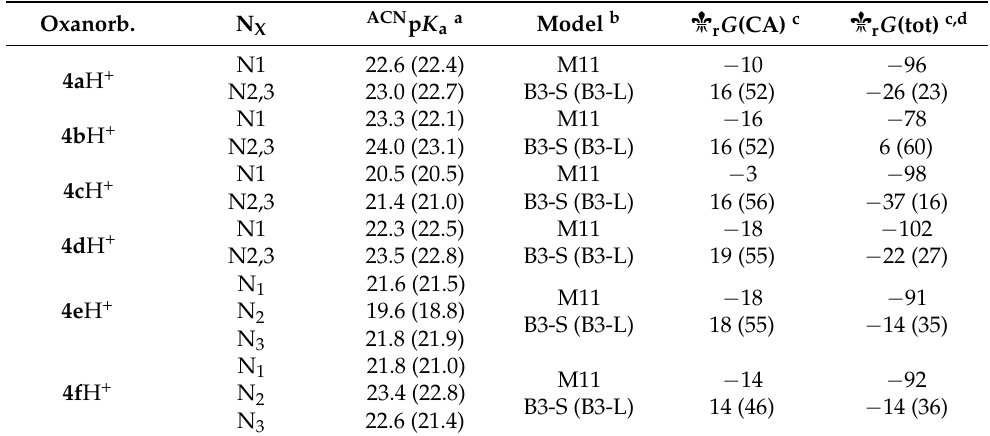
Table 2. Calculated ACN p K a s for all three positions in the guanidine subunit and the Gibbs energies of the reaction for the cycloaddition and cyclization of the oxanorbornadiene ions 4a H + – 4f H + .